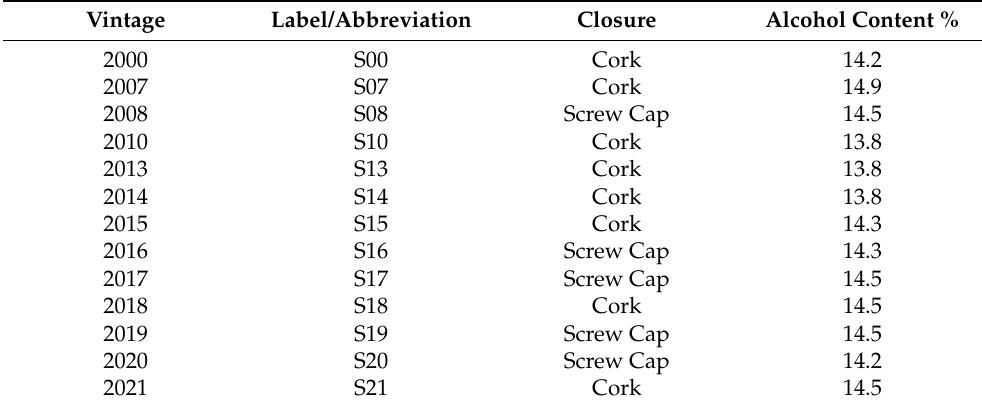
Table 1. Shiraz vertical vintages used for this study, including abbreviation, closure type, and alcohol